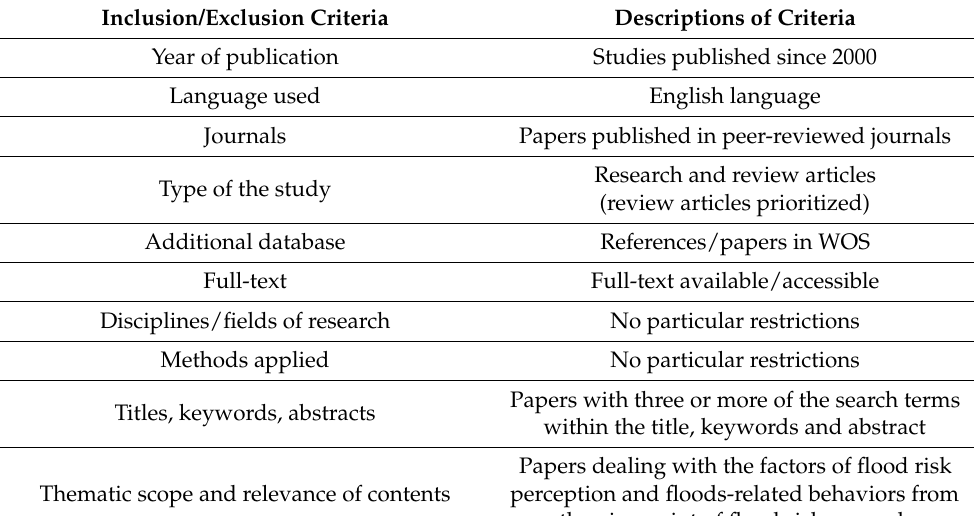
Table 1. Inclusion and exclusion criteria used and their